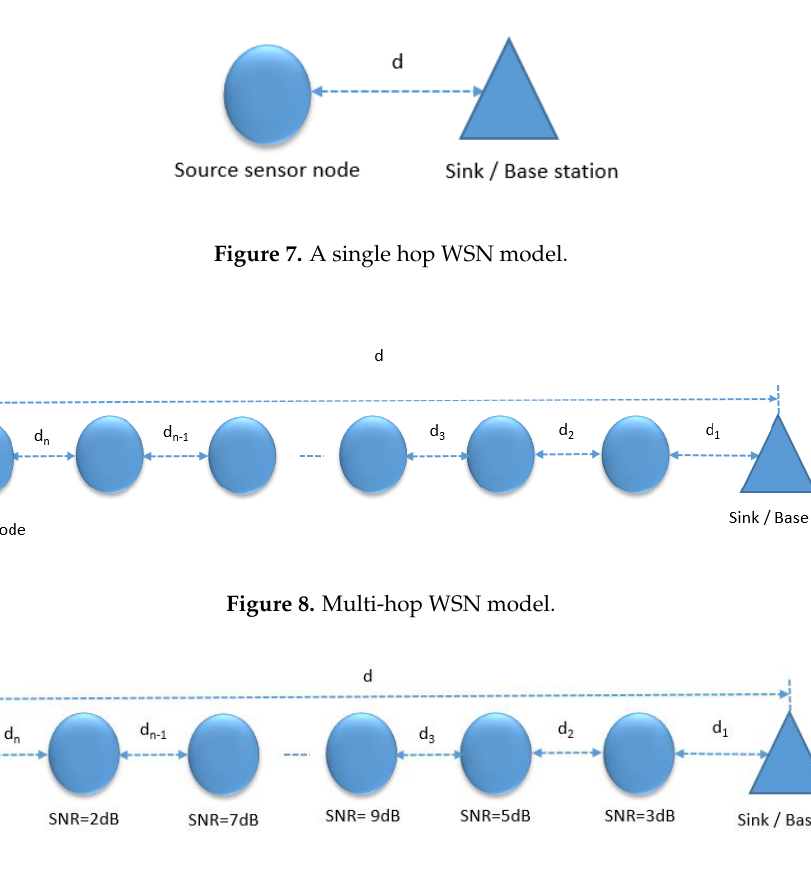
Figure 9. Modified multi-hop WSN